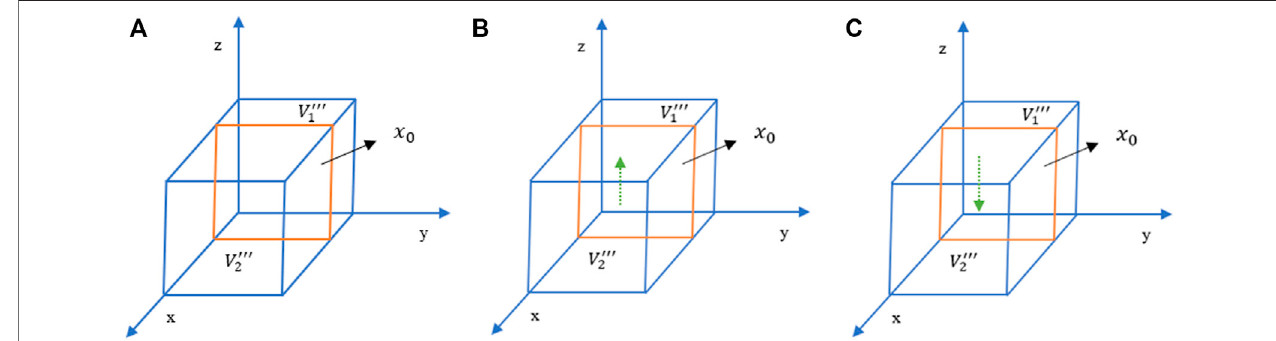
FIGURE 5 | Dynamic evolution trend of the behavior of the LGs. (A) x − x 0 . (B) x < x 0 . (C) x > x 0 .